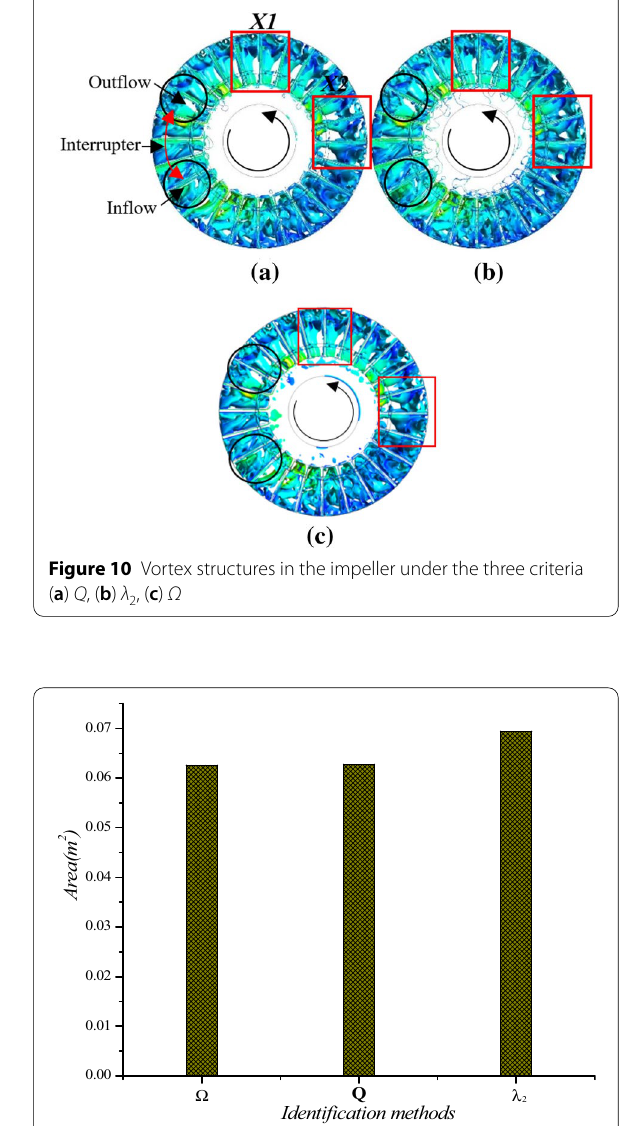
Figure 11 Vortex areas identified under the three